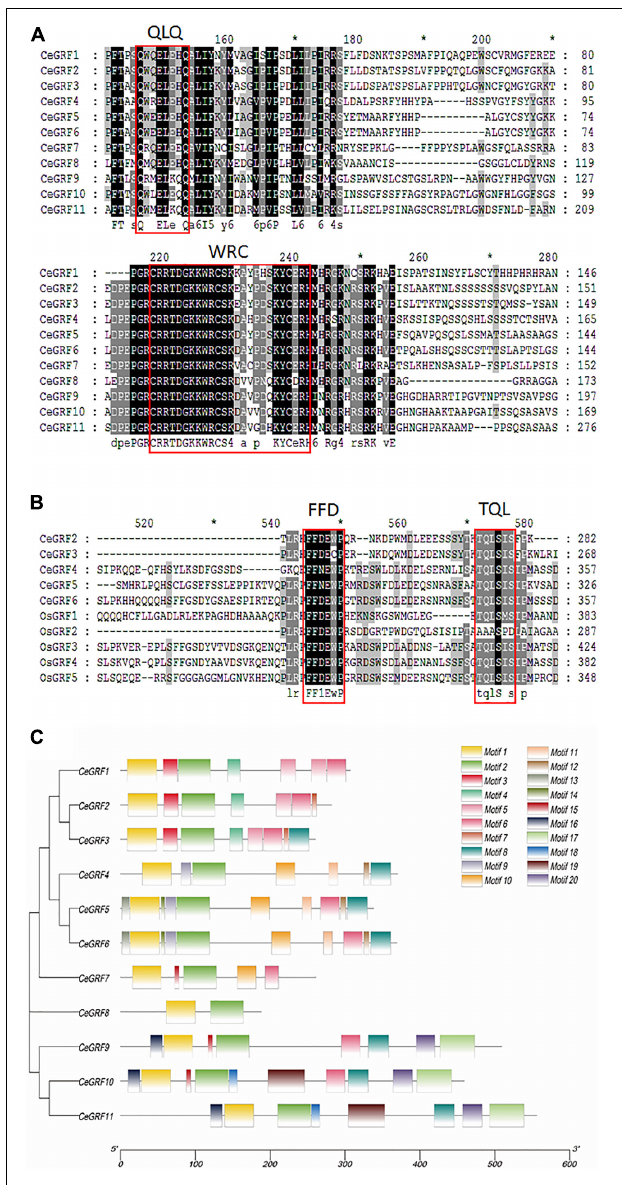
FIGURE 2 | Sequence alignment and functional domain analysis of Cymbidium ensifolium Growth-Regulating Factor (CeGRF) proteins. The conserved QLQ and WRC domains in all CeGRFs (A) and the FFD and TQL motifs identified in CeGRF2, 3, 4, 5, and 6 (B) are indicated by the red box. Identical amino acids are indicated by black and the amino acids with > 50% similarity are indicated by gray background. (C) Twenty conserved motifs labeled with different colors were identified in the CeGRF sequences using the MEME program. Among them, motif 1 and motif 2 are the QLQ and WRC conserved